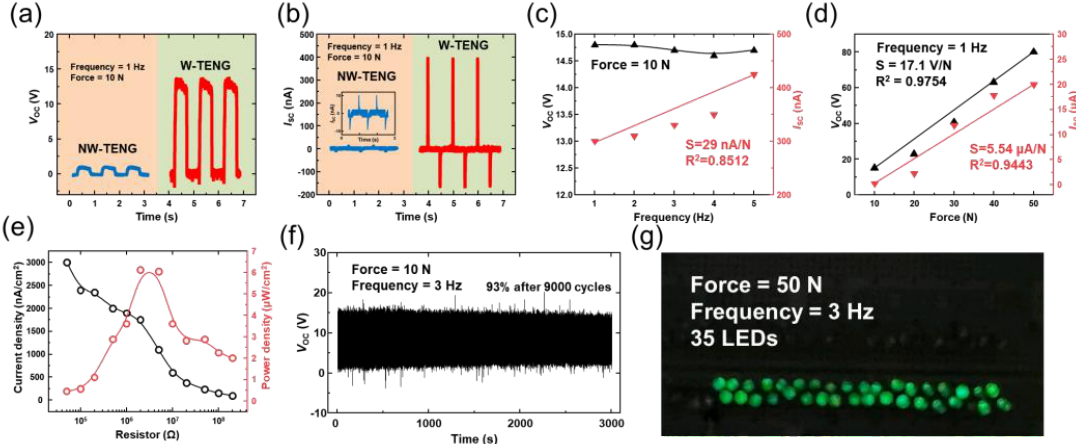
Figure 2. Electrical characteristics of the non-wrinkled TENG (NW-TENG) and wrinkled TENG: ( a ) V OC and ( b ) I SC . ( c ) Frequency-dependence of W-TENG. ( d ) Force-dependence of W-TENG. ( e ) De- pendence of the load resistance on current density and output power of W-TENG. ( f ) Durability of W-TENG. ( g ) Serial connection of LEDs with